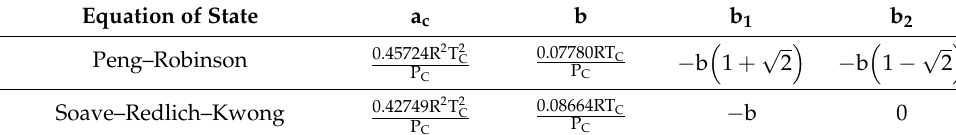
Table 1. Parameters of the Peng–Robinson and Soave–Redlich-Kwong equation. Equation of State a c